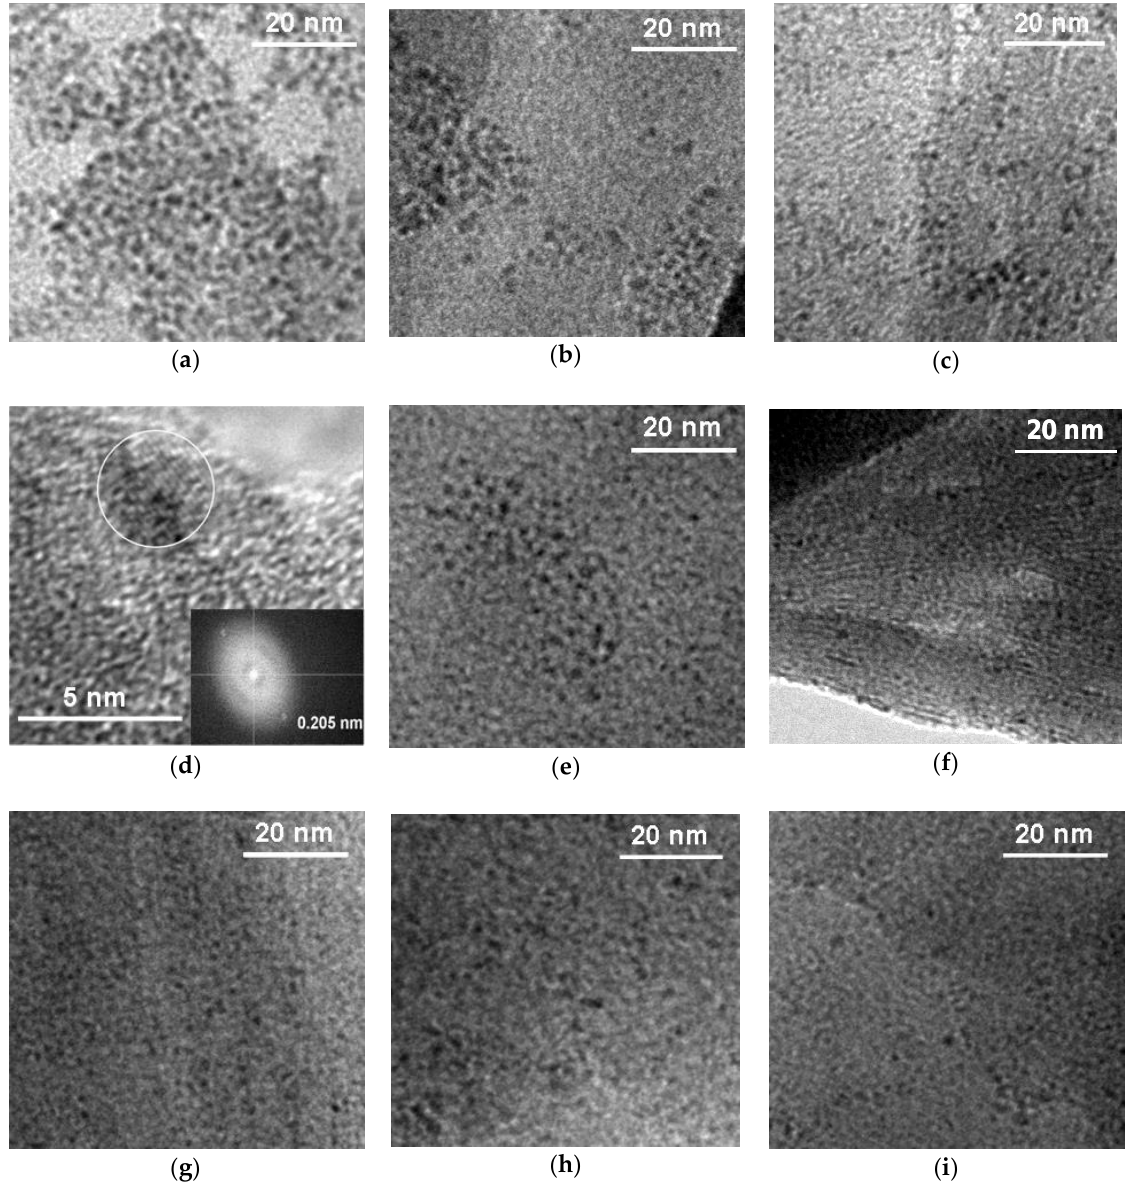
Figure 5. TEM images of Ru particles in: ( a ) Mt/(Ru + PDDA_0.01); ( b ) Mt/(Ru + PDDA_0.05); ( c ) Mt/(Ru + PDDA_0.25); ( d ) HRTEM image of Ru crystallite in Mt/(Ru + PDDA_0.05) with corresponding FTT; ( e , f ) Mt/(Ru + PDDA_0.05)post; ( g ) Mt/PDDA_0.05/Ru; ( h ) Mt/(Ru + PDDA_0.25)post; ( i ) Mt/PDDA_0.25/Ru.